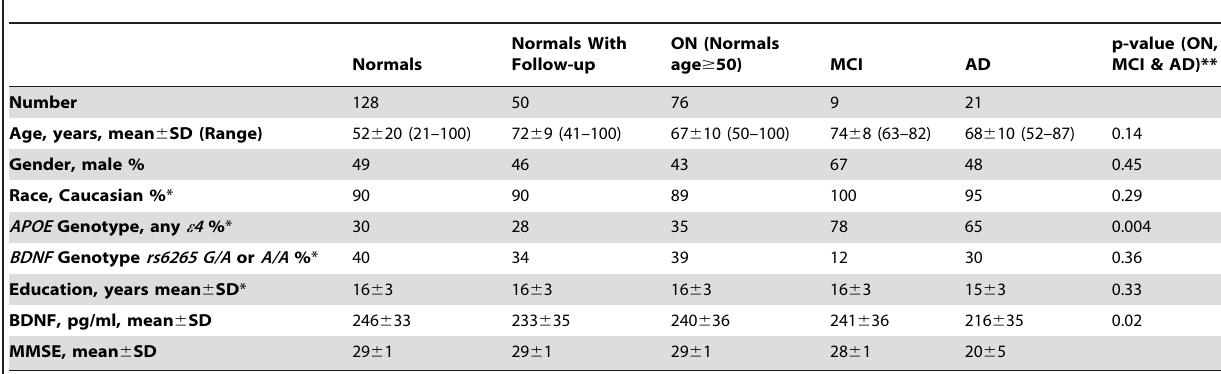
Table 1. Subject characteristics and CSF BDNF levels at